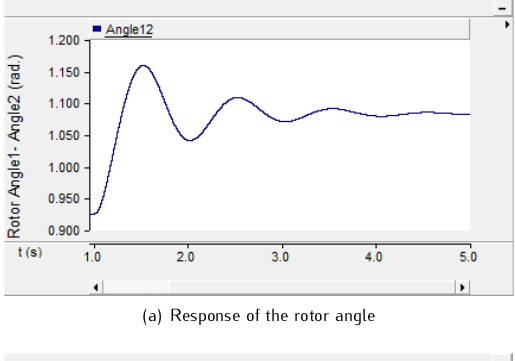
Table A.1 A Two-Machine System Parameters